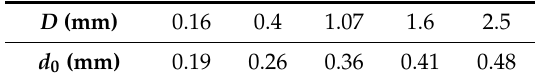
Table 3. The diameter of droplets generated by syringe needle of different diameters.